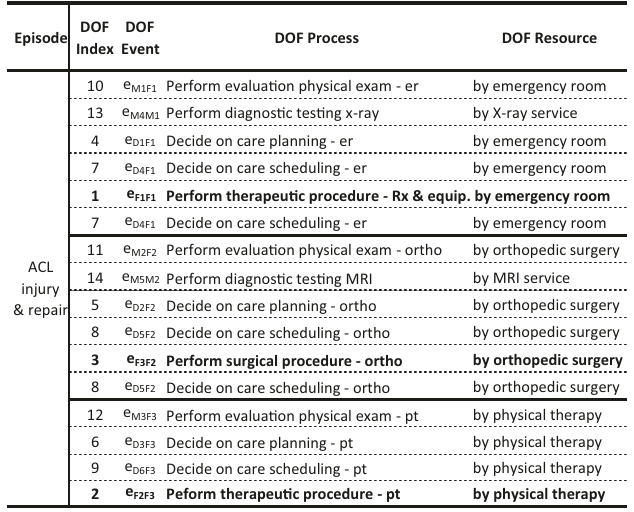
Figure 8: Orthopedic acute episode described in terms of the healthcare delivery system events found in 𝐽 𝐹𝐷𝑀 . The healthcare delivery trans- formational events are in bold.